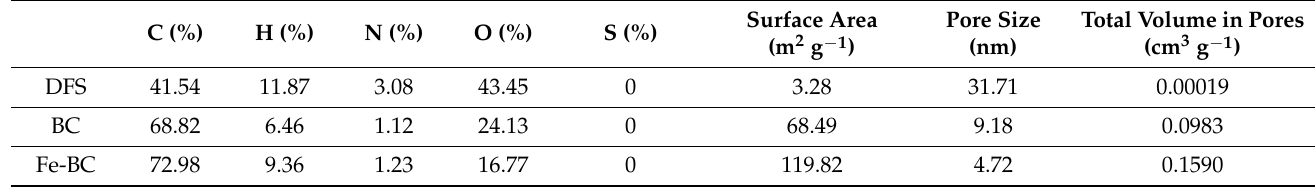
Table 2. Elemental composition and surface characteristics of date palm waste (DFS), biochar (BC), and Fe-modified biochar (Fe-BC).